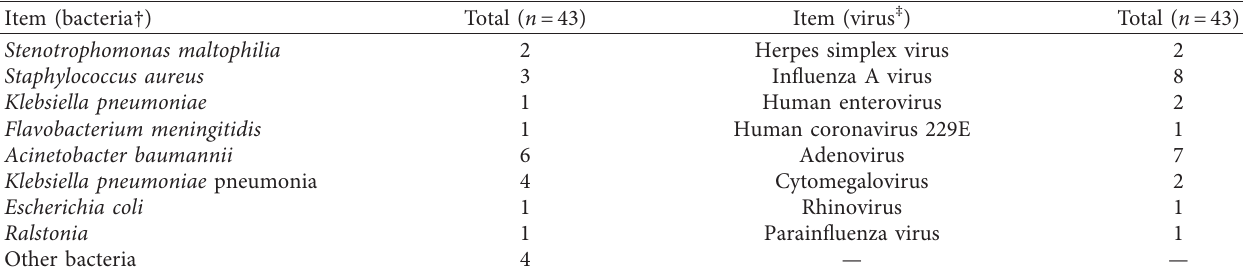
Table 2: Bacterial and viral test